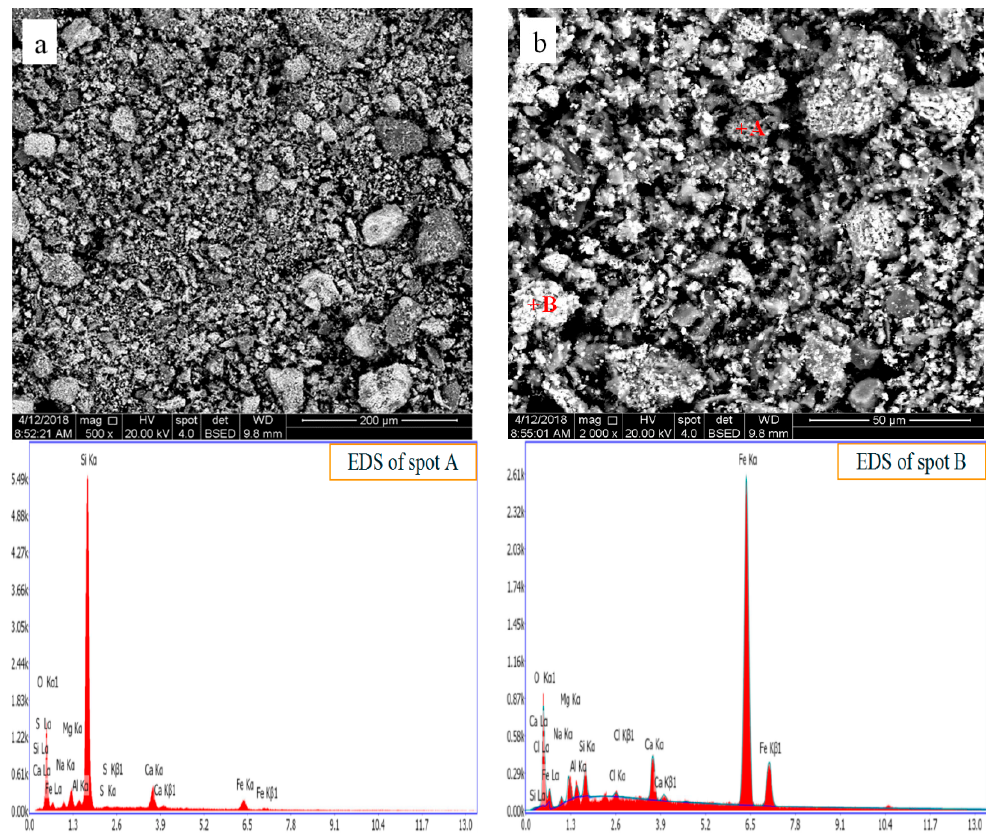
Metals 2018 , 8 , x FOR PEER REVIEW Figure 8. SEM-EDS images of CT after chlorination roasting in the conventional field. ( a ): low magnification image; ( b ): magnified image of local area in ( a ).